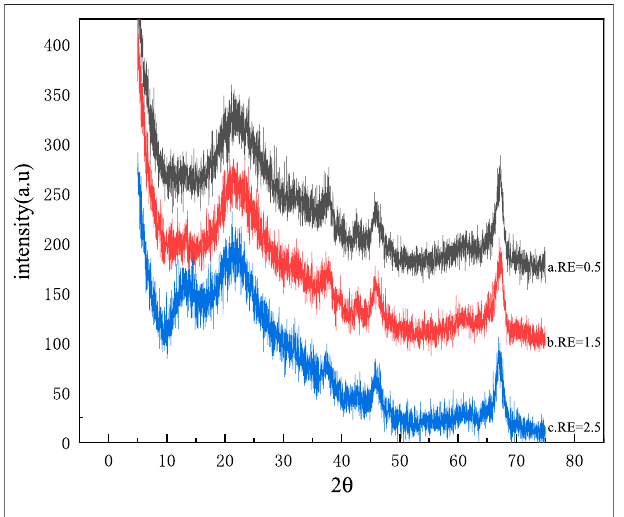
FIGURE 6 | XRD patterns of mineral polymer precursors synthesized with different amounts of ethanol.